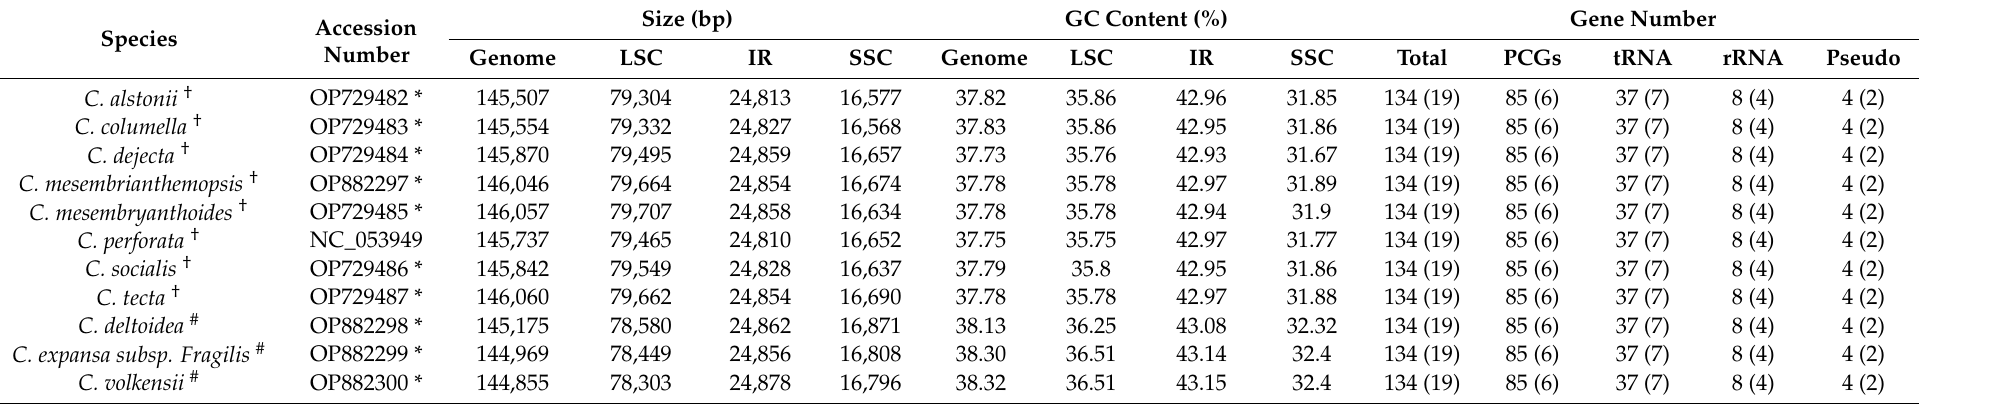
Table 1. Plastome characteristics of Crassula